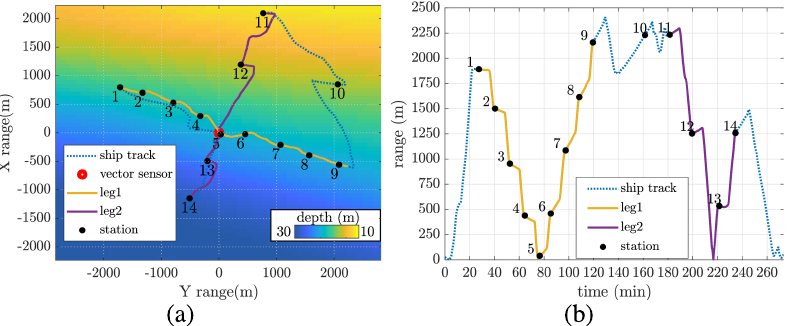
Figure 2. EMSO’21 experiment: ship track over area bathymetry in X–Y range centered at vector sensor/tripod position (37.04235 ◦ N, − 8.16359 ◦ W), and transmitting stations ( a ); range between ship and vector sensor position along time ( b